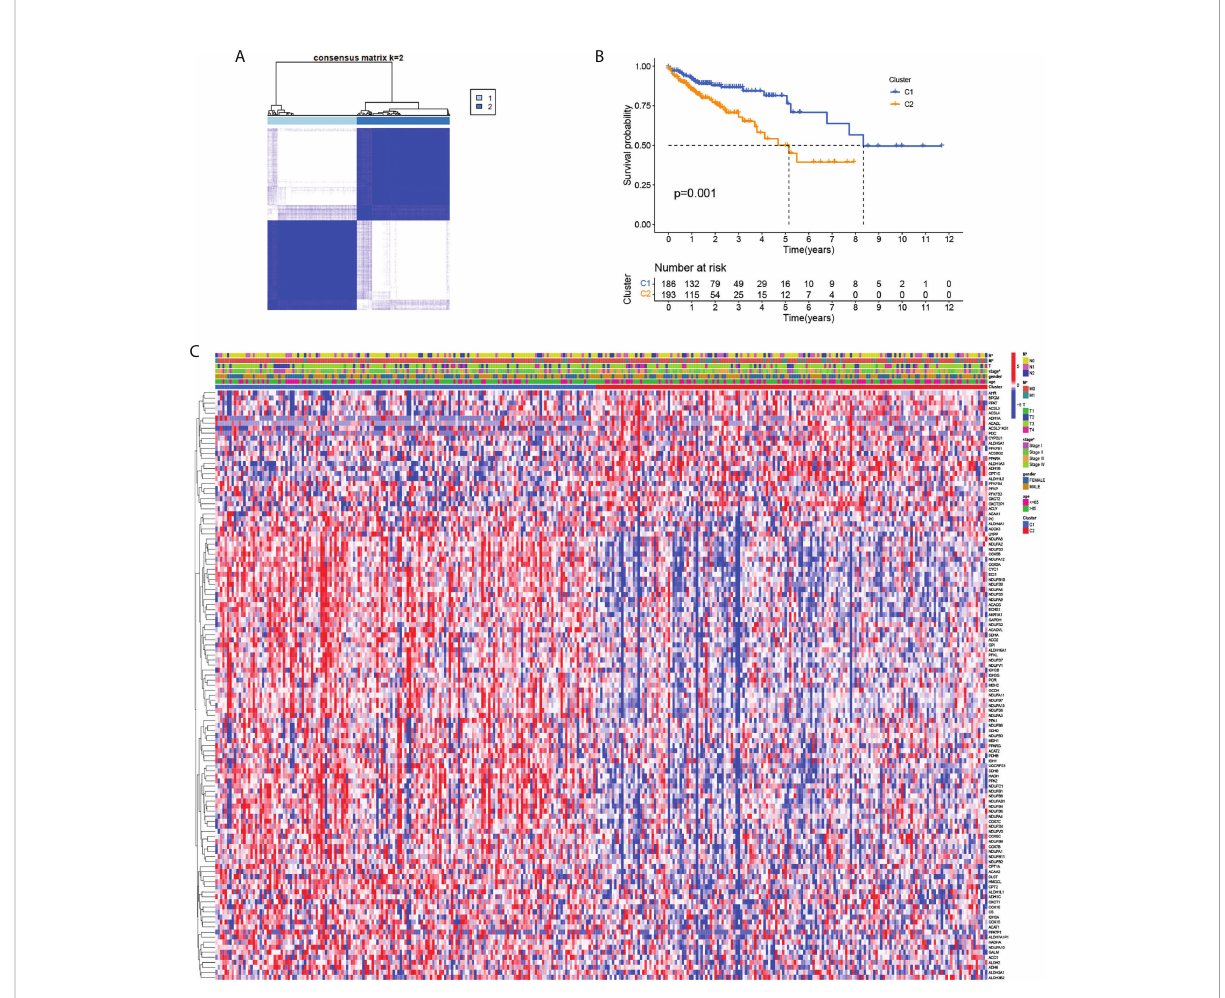
FIGURE 4 Tumor classi fi cation based on the MMRGs. (A) COAD patients were grouped into two clusters according to the consensus clustering matrix (k = 2). (B) Kaplan – Meier curves for the two clusters. (C) Heatmap for the expression of MMRGs and clinical features between two clusters; red represents high expression, and blue represents low